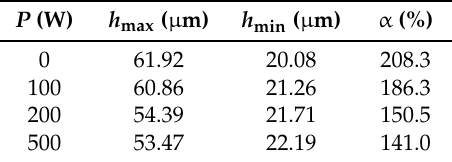
Table 2. Dependence of α on ultrasonic power.